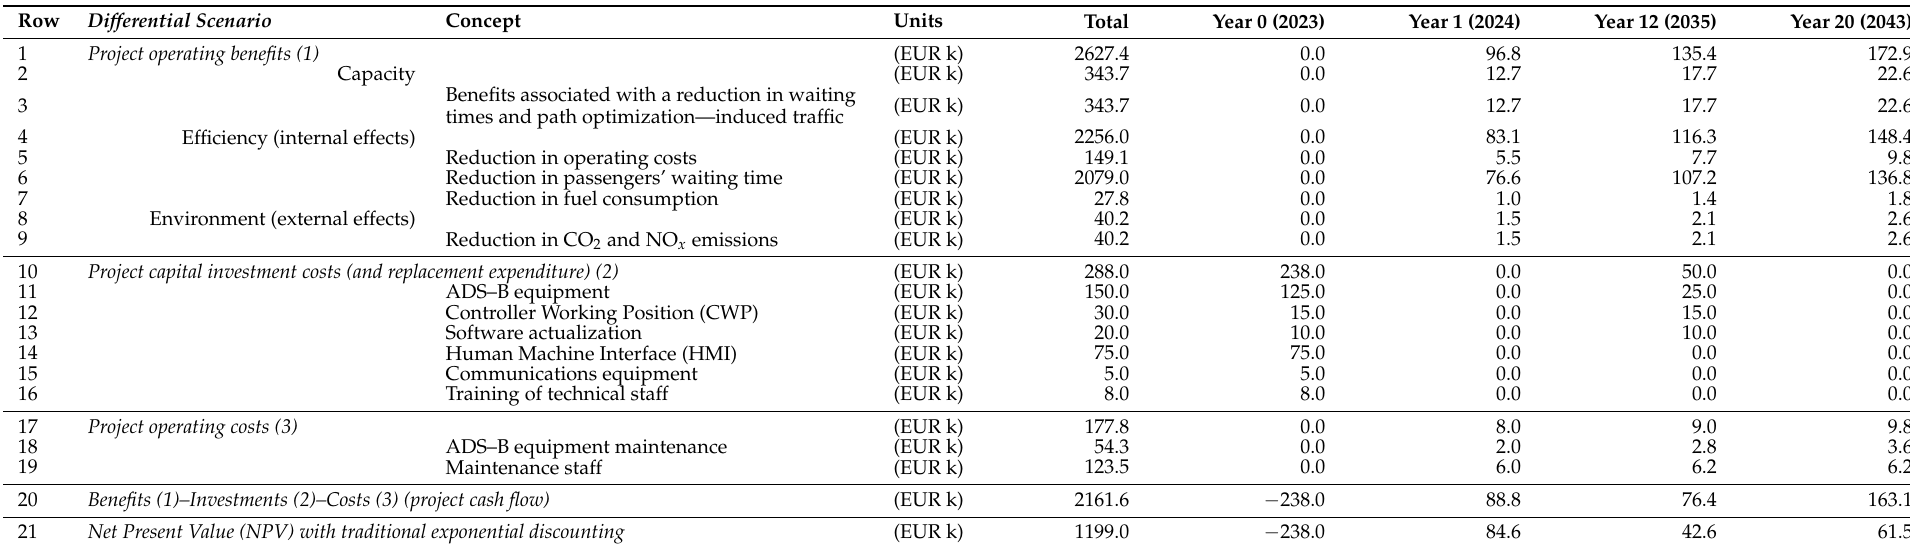
Table 1. Traditional CBA for the implementation of ADS–B technology at an